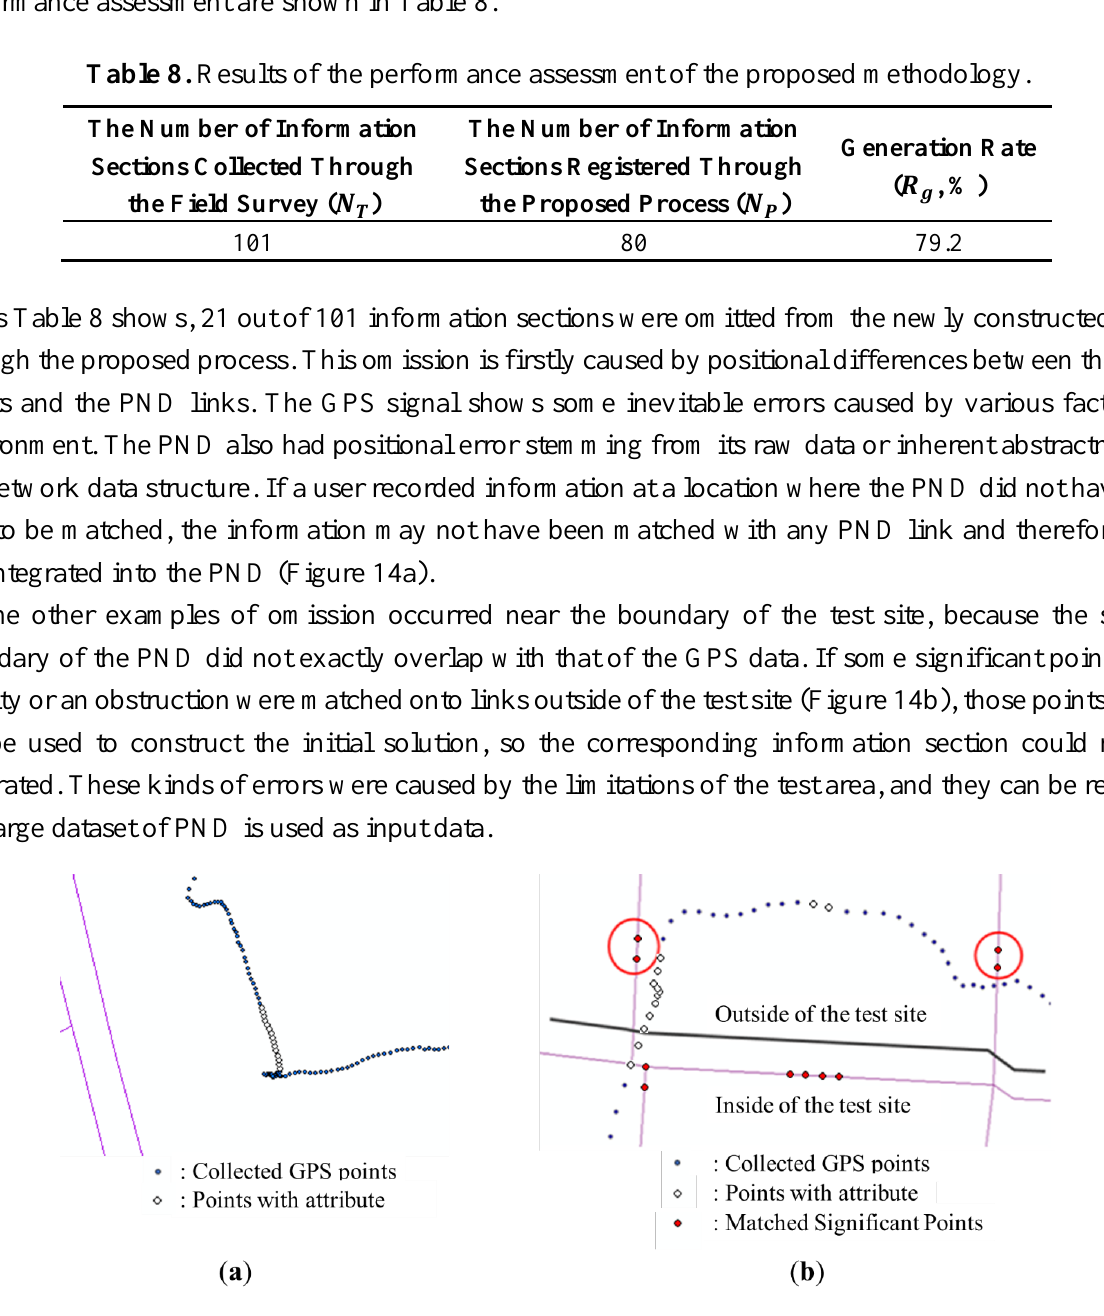
Figure 14. Examples of omission occurred because: ( a ) information was recorded where the PND did not have any link to be matched; ( b ) the boundary of the PND was not exactly coincident with that of the GPS